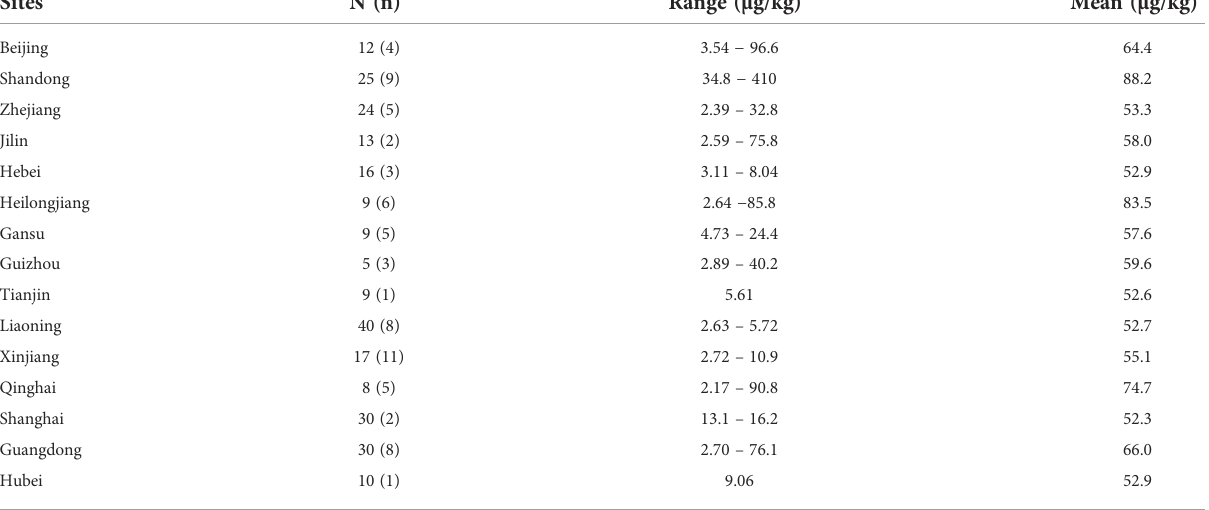
a N, the number of sample in sites; (n) the number of positive sample. b The concentration for positive detection. c Antibiotic concentrations below LOD were replaced with those of LOD/2.